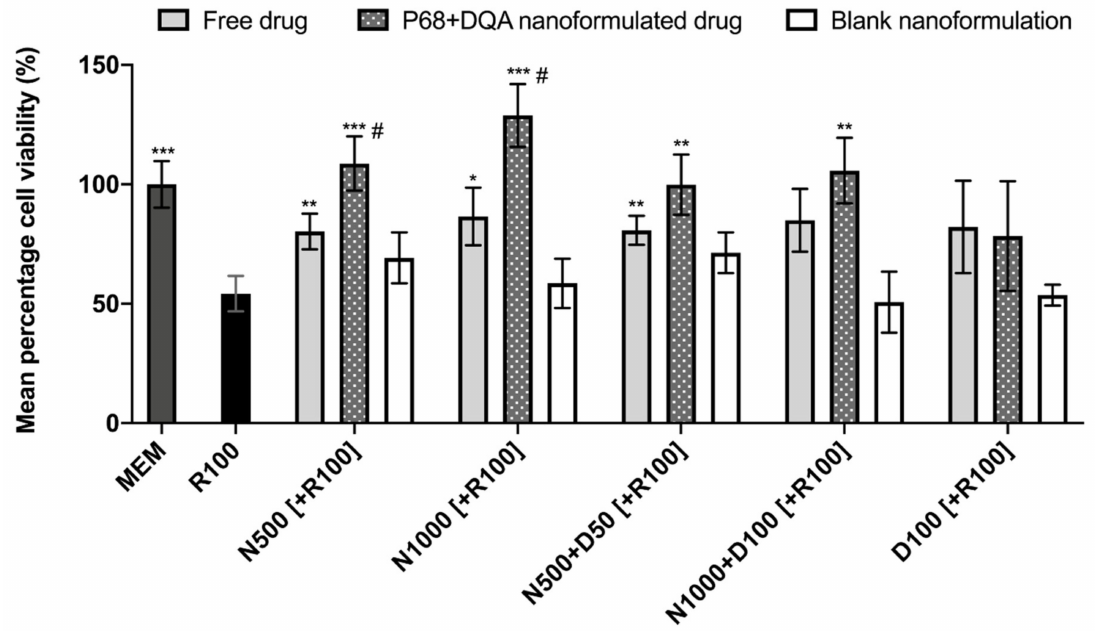
Figure 3. MTT assay results of 3 h pre-treatment with free-drug, P68 + DQA nanoformulated and corresponding blank preparations of either 500 and 1000 µ M NAC (N500, N1000), combined NAC with 50 or 100 µ M DFO (N500 + D50, N1000 + D100) or 100 µ M DFO alone (D100) followed by 24 h treatment with 100 µ M rotenone (R100) compared to R100 treatment alone. MEM represents the control condition where cells were only treated with media, no pre-treatment nor R100 treatment (mean ± S.D., n = 6). * represents significance values of control or pre-treatment conditions compared to R100 treatment alone (*** p < 0.001, ** p < 0.01, * p < 0.05). # represents significance values of nanoformulated drug compared to free drug within the same treatment condition (# p <